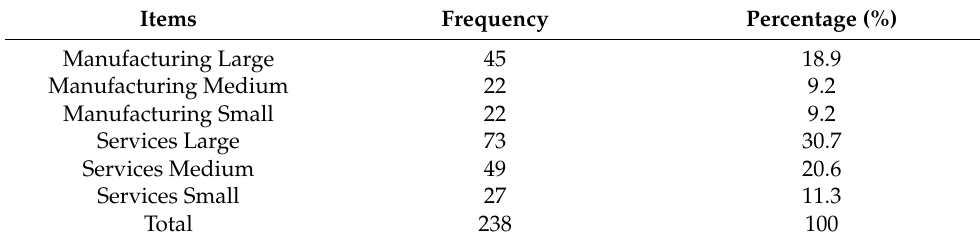
Table 3. Organization